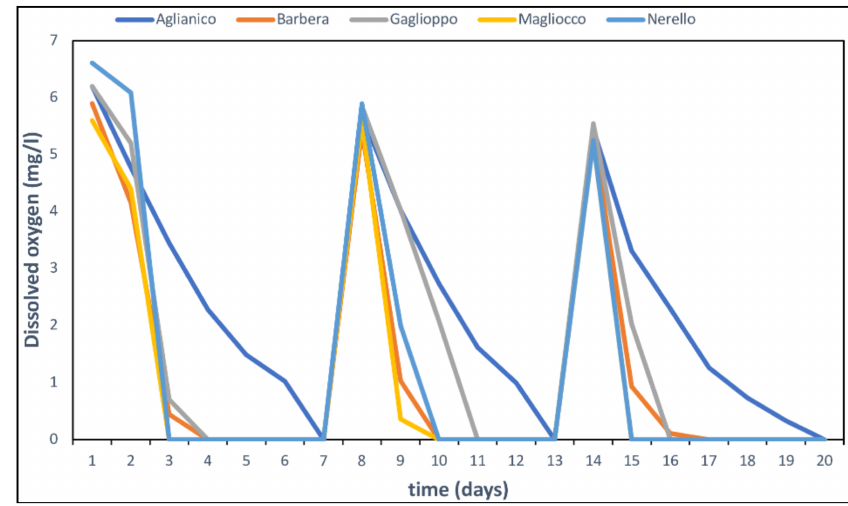
Figure A1. Dissolved oxygen in wines treated with three cycles of saturation (sat).